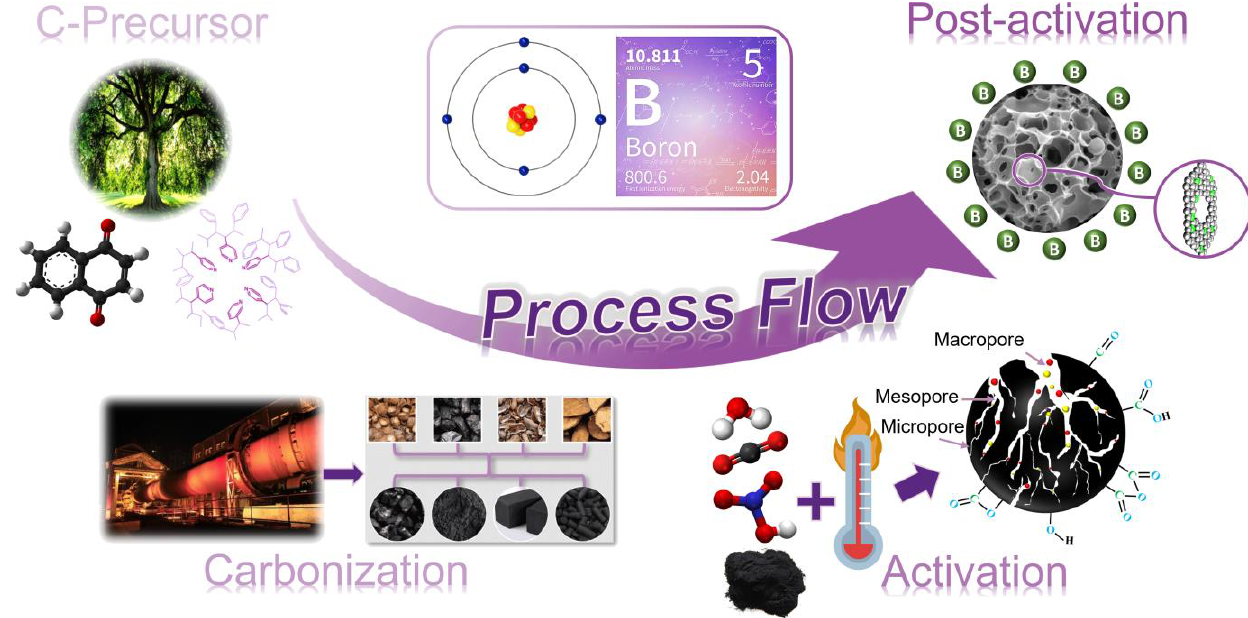
Figure 6. Sketch of different boronation techniques of ACs.